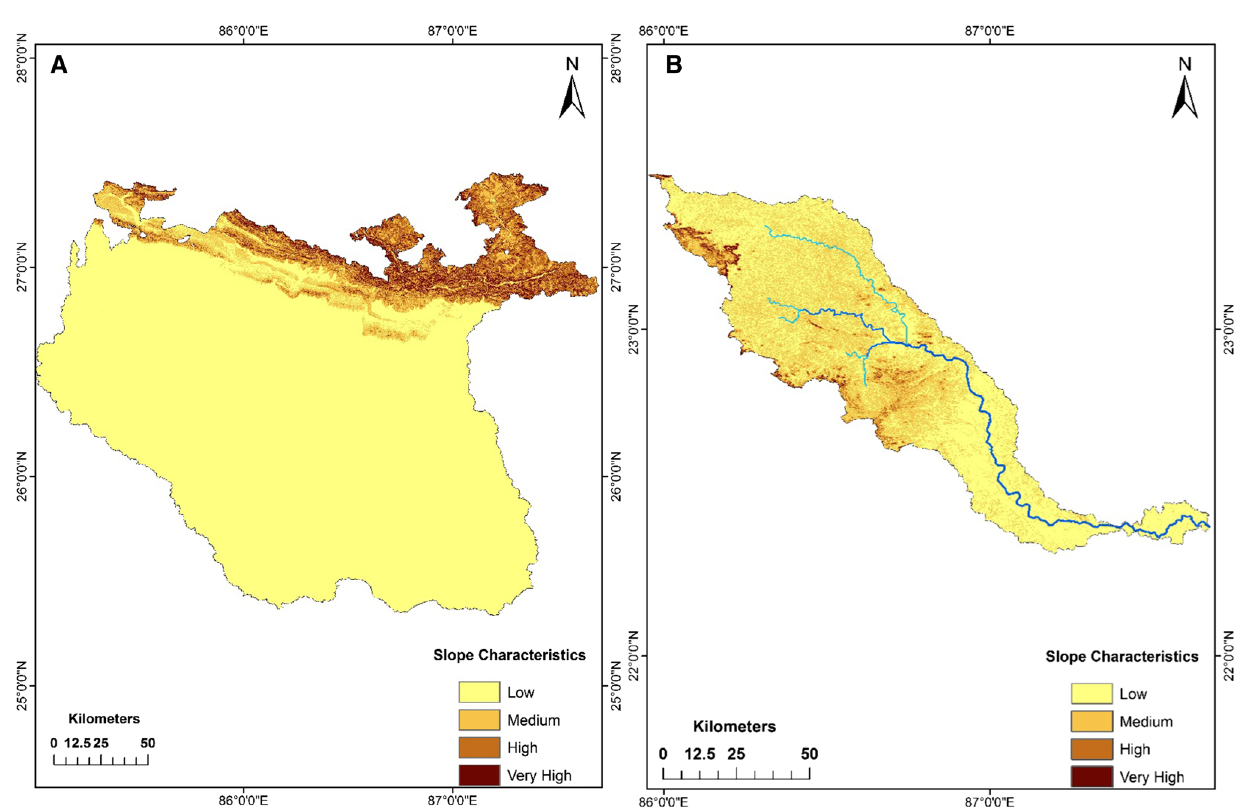
Fig. 6 Slope characteristics of River basins a Kosi and b